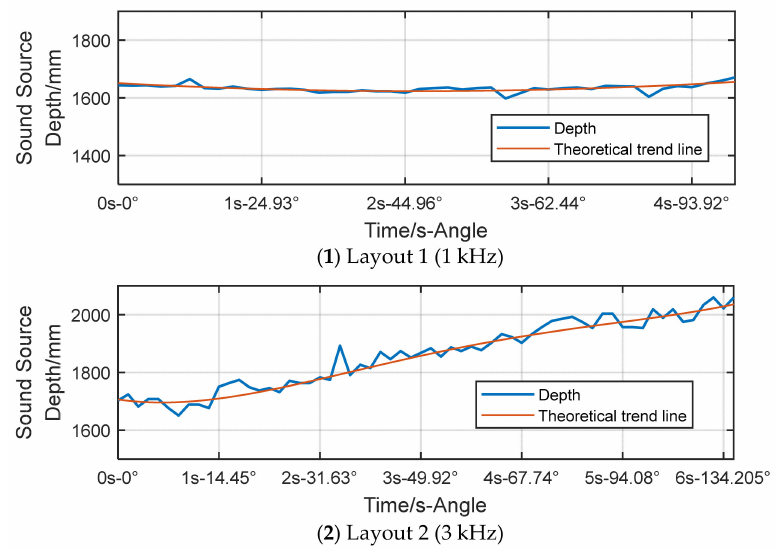
Figure 9. Sound source depth versus time-angle.